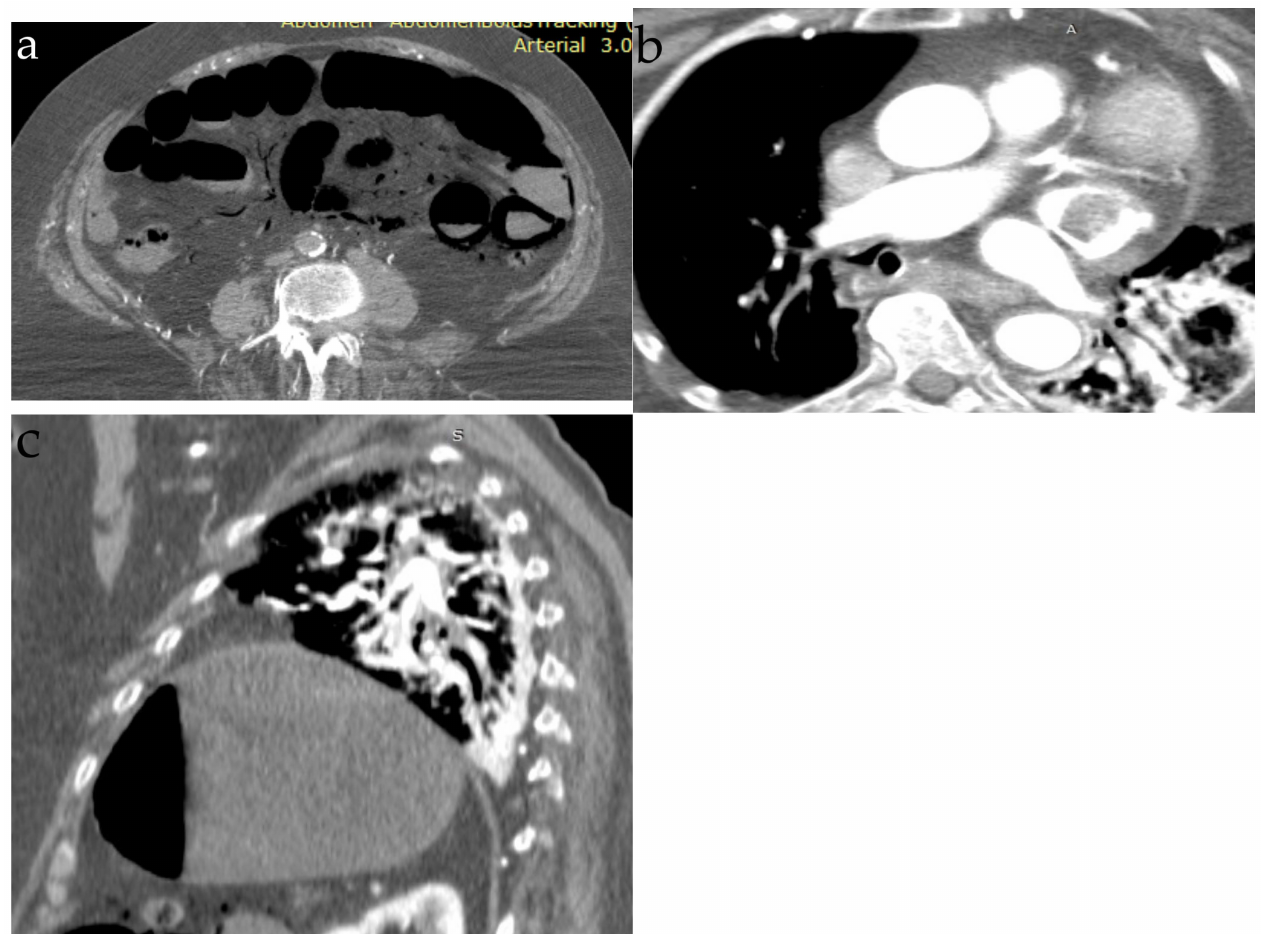
Figure 1. Thoraco-abdominal CT; ( a ) arterial acquisition with air within the branches of the supe- rior mesenteric artery; ( b , c ) segmental pulmonary embolism, nonspecific (from the collection of dr. Fotea